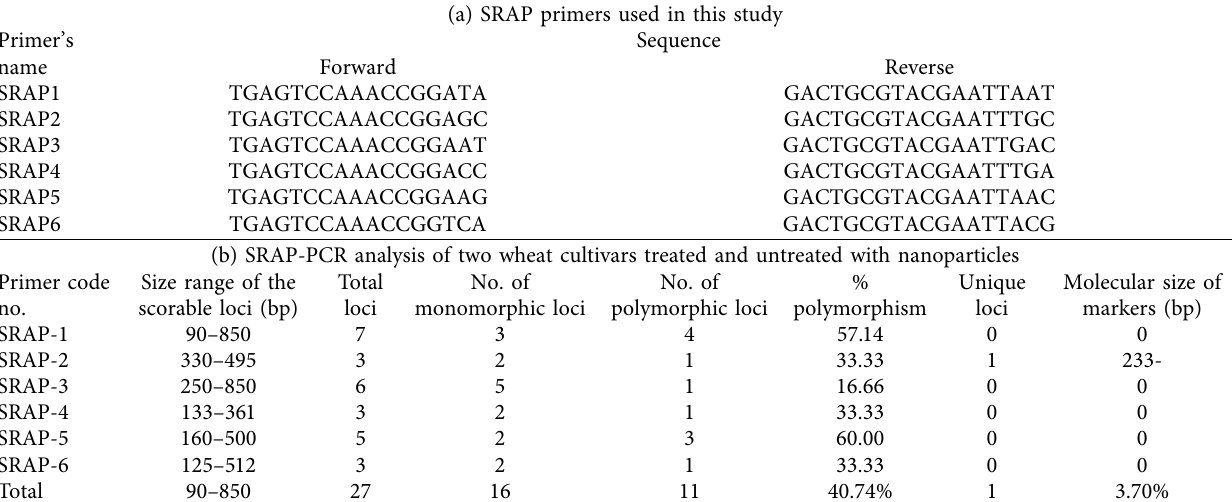
Table 3: SRAP-PCR analysis of two wheat cultivars (Gimeza 12 & Sids 13) treated with nano TiO2 or ZnO (10mg/l) subjected to different levels of water irrigation requirments at 75 days from sowing.